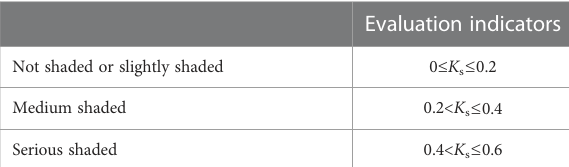
TABLE 2 Index of shaded pear ’ s degree in the dataset.